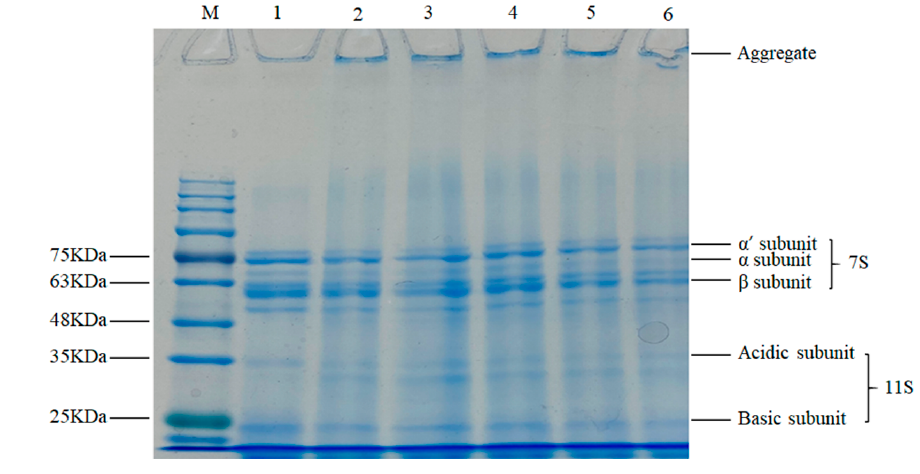
Figure 3. SDS–PAGE profile of SPI with different storage times.